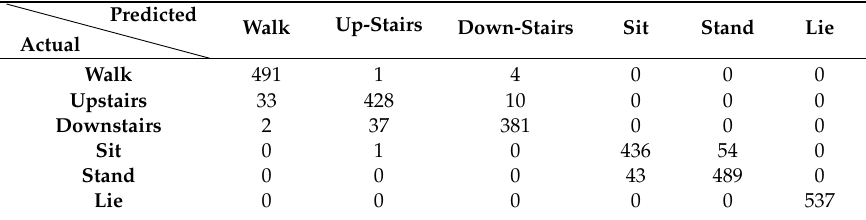
Table 4. Confusion matrix of best-performing classifier ADA(RF) using reduced feature set.